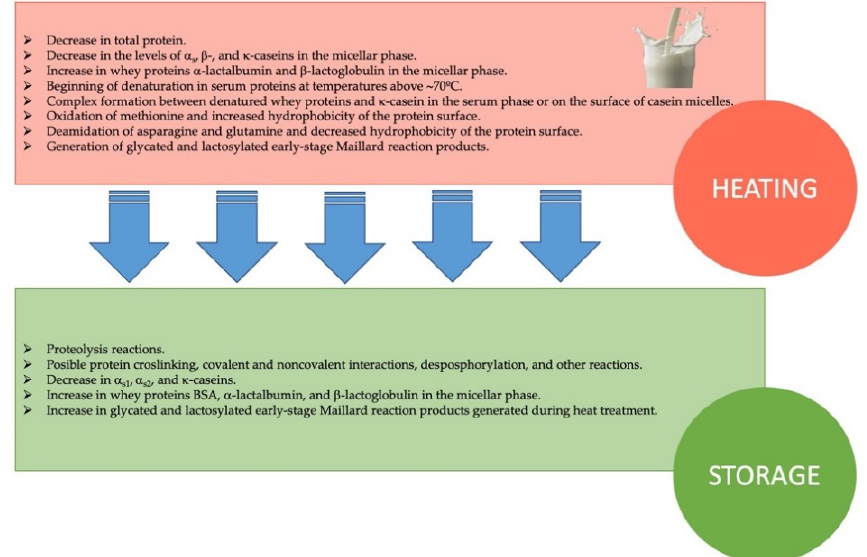
Figure 3. Possible modifications of milk proteins during heat treatment and subsequent storage. Data from Liu et al. [117].